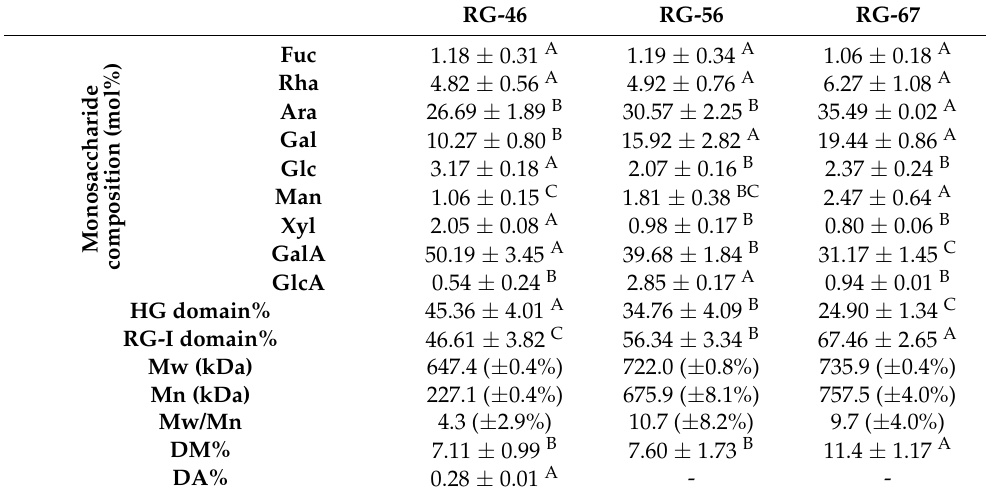
Table 1. Analysis of monosaccharide composition, molecular weight, and degree of